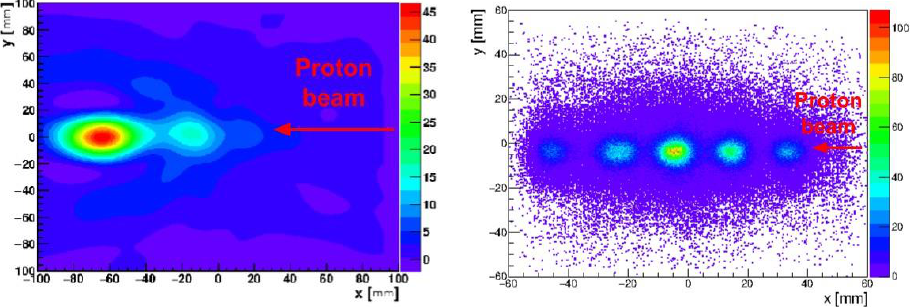
Figure. 2. Left panel: PG monitoring using Compton imaging for i-TED-B during the beam-on phase of the Nylon proton irradiation. Right Panel: PET imaging obtained during the Beam-off period of the same